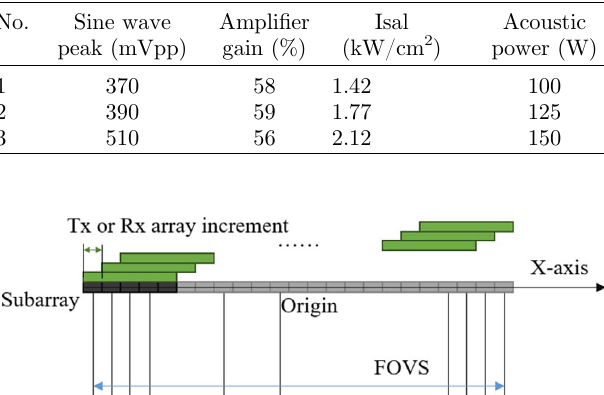
Figure 2. System working sequence. Table 1. Sound power setting conditions.